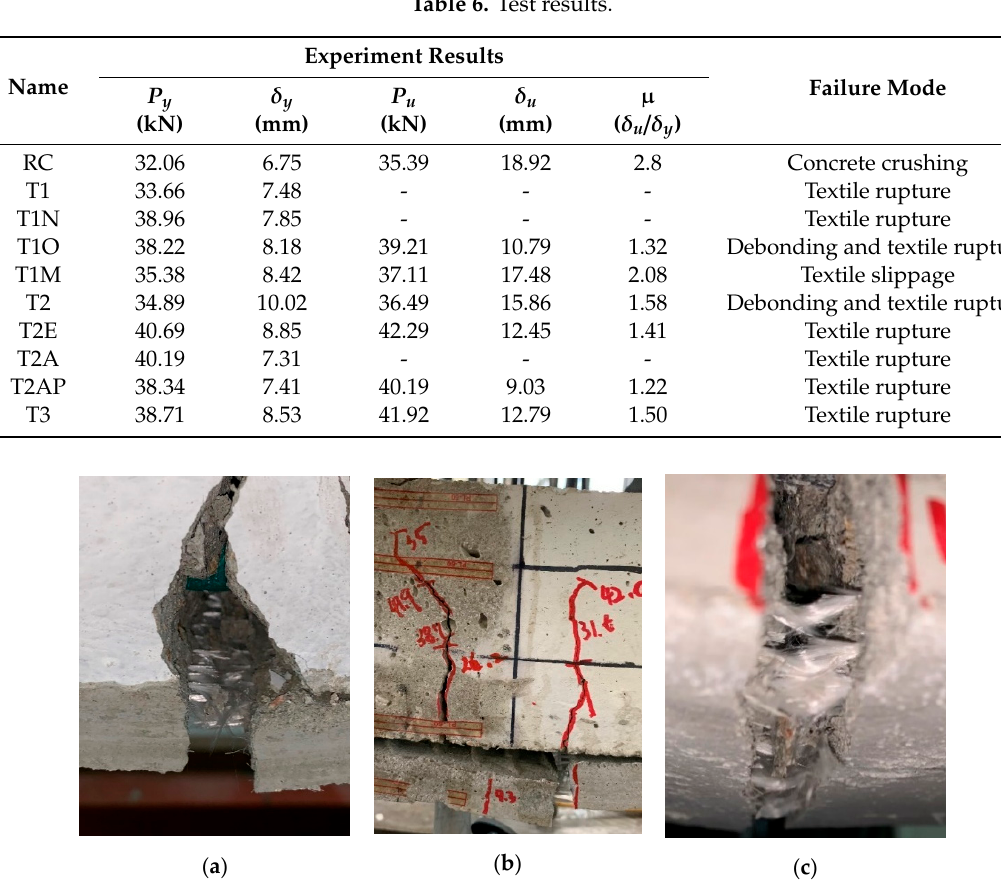
Figure 7. Failure modes of TRM: ( a ) Textile rupture of T2AP; ( b ) debonding and textile rupture of T2; ( c ) textile slippage of T1M.